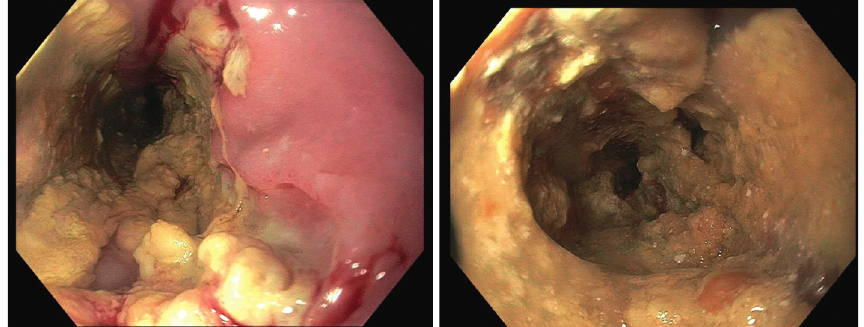
Figure 2: Multiple, deeply cratered ulcers, in a circumferential manner with adherent food debris (a), causing severe narrowing of the esophageal lumen, in a near complete food bolus impaction (b).